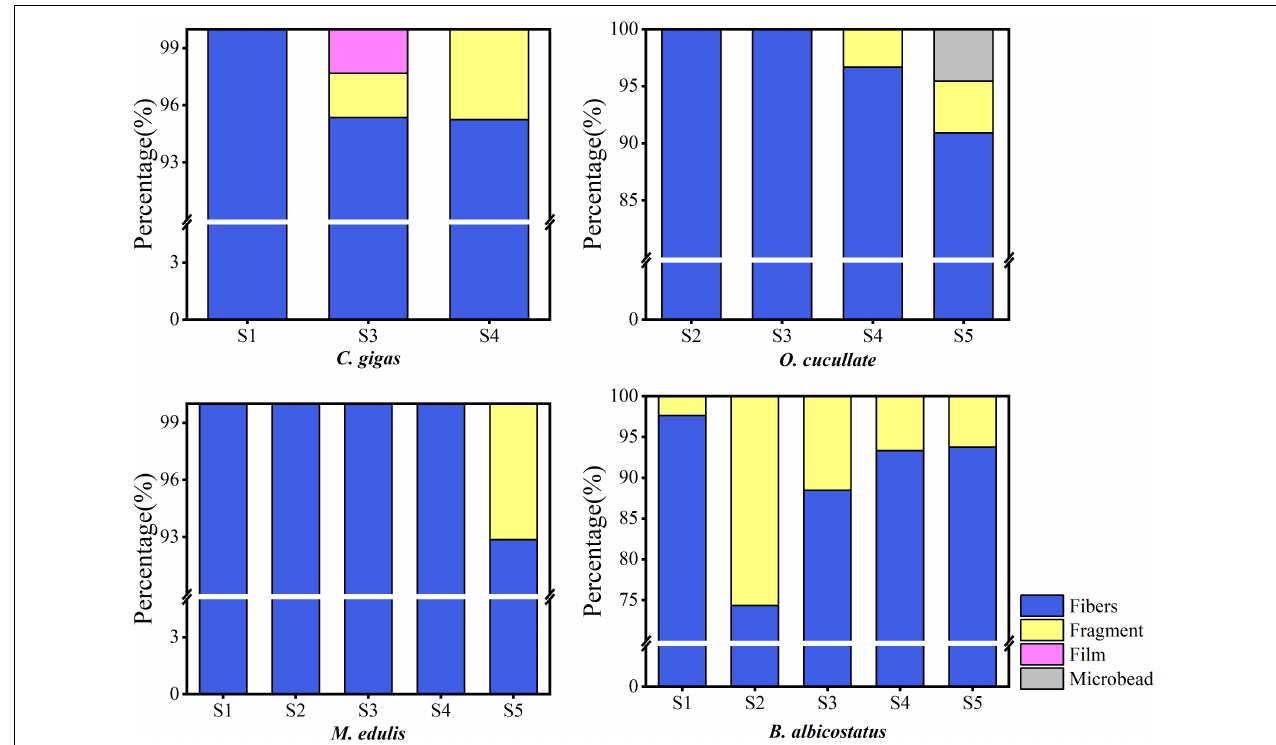
FIGURE 4 | Shape distribution of MPs in four species of barnacles and wild bivalves from different sites in the Yellow Sea.